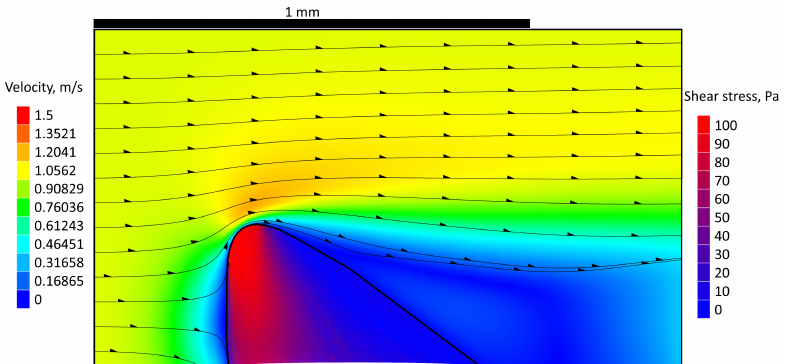
Figure 4. The velocity contour plot and streamlines for melt area and the shear stress contour plot for the dendrite tip area. The fluid flow has a 60-degree slope to the dendrite axis.